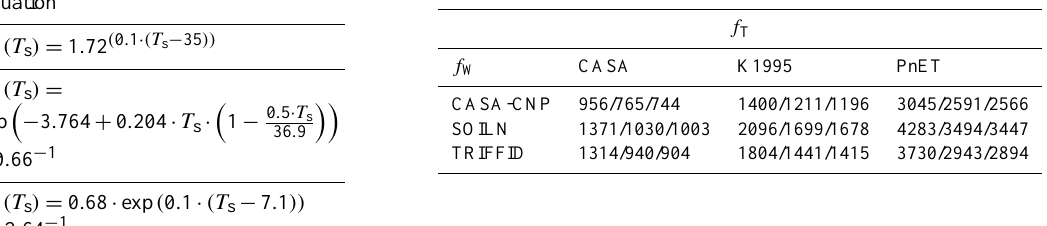
Table 2. Formulations of f T implemented in the CASA-CNP model ( T s : soil temperature in ◦ C).